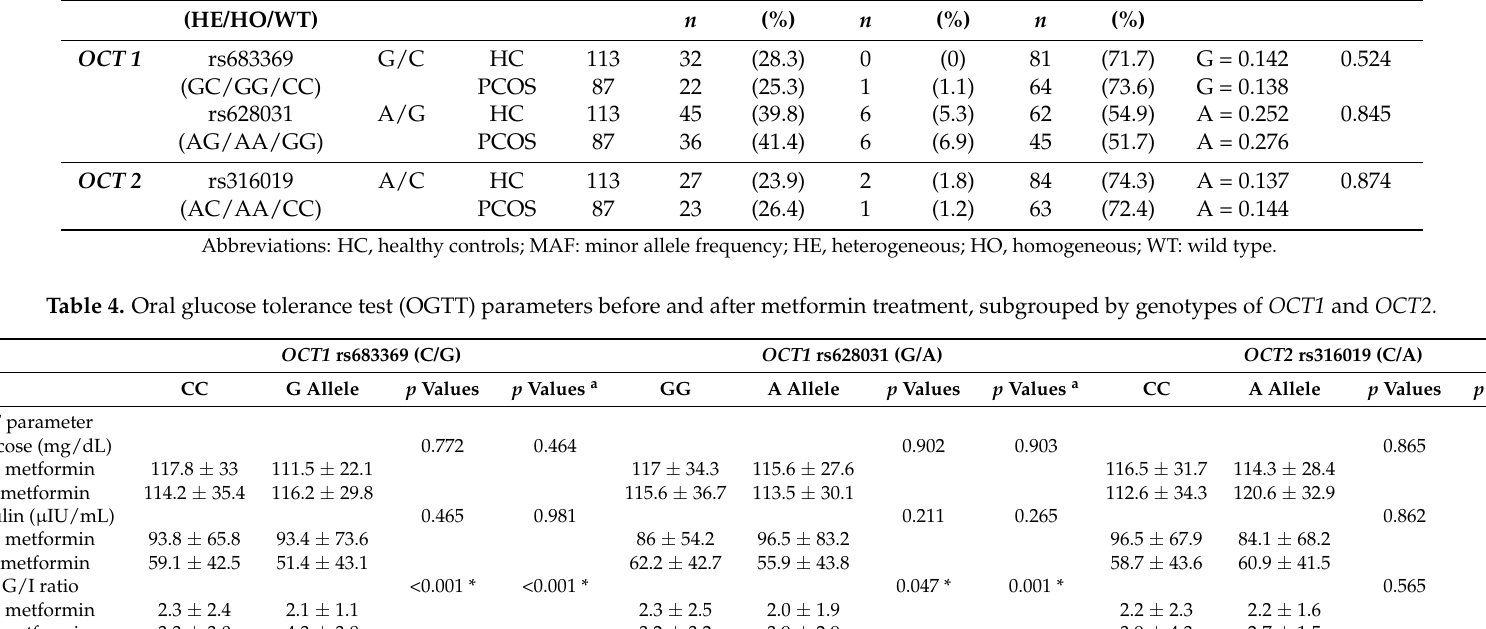
Table 3. Genotypes and allele frequencies of organic cation transporter ( OCT) 1 and 2 in healthy controls and PCOS patients.